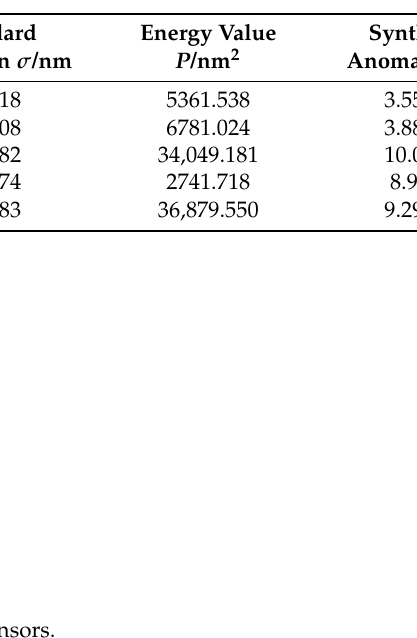
Table 3. Features values and synthetical abnormal index of five faulty FBG sensors.